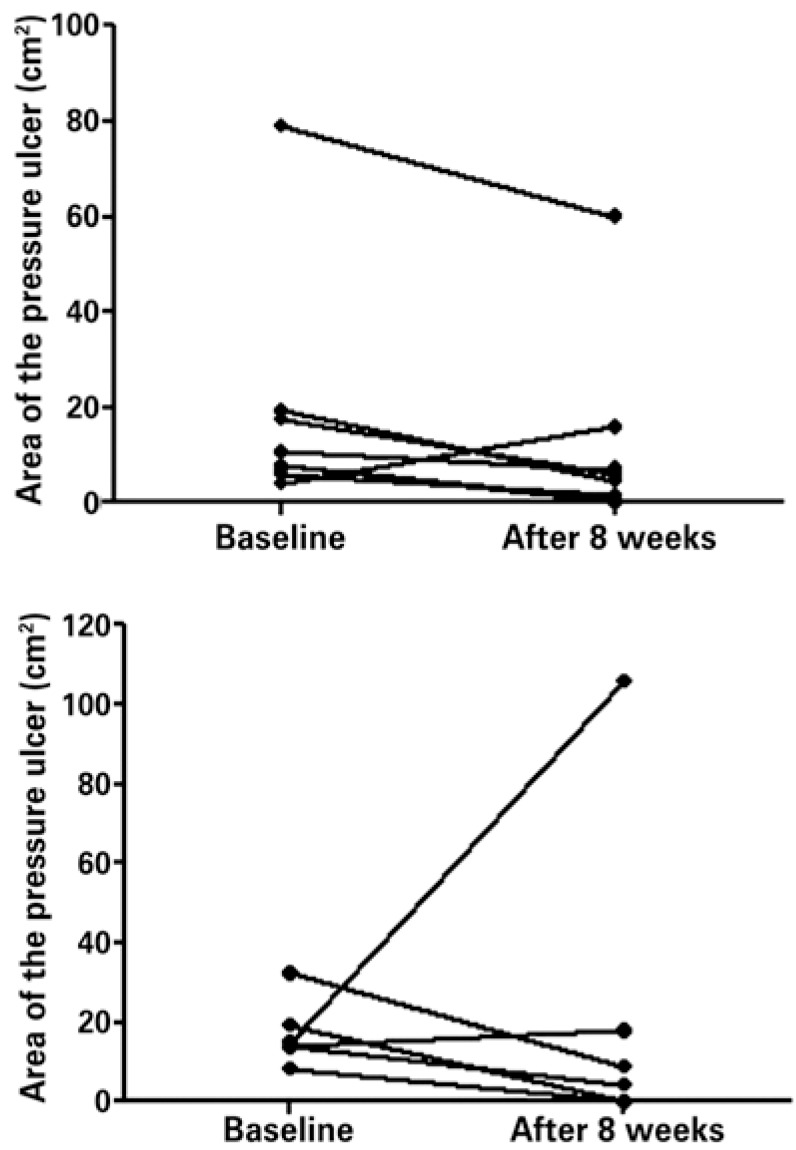
Measurements of pressure ulcers (cm2) in 11 inpatients at a long-term care stay hospital before and after treatment (A) collagenase (n=8) and (B) sulfadiazine (n=6) for 8 weeks. No significant differences were observed in baseline values and those after treatment during the follow-up period (p>0.05)